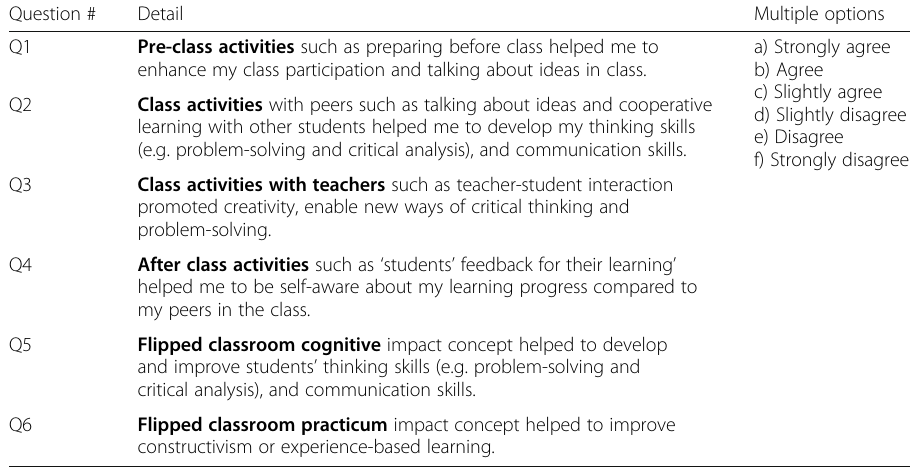
Table 1 Six questions to students about the course